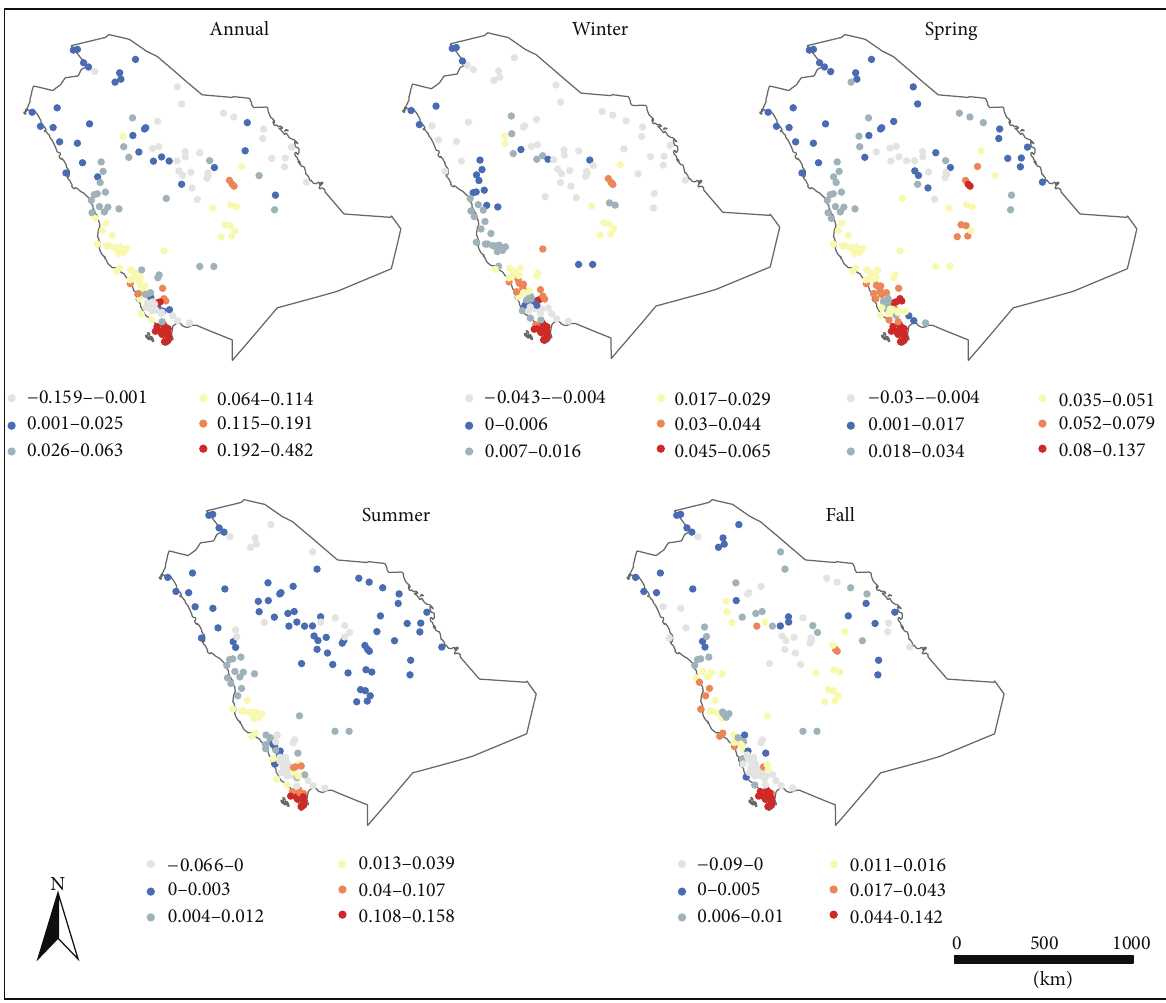
Figure 9: GWR parameter estimation of the altitude for annual and seasonal